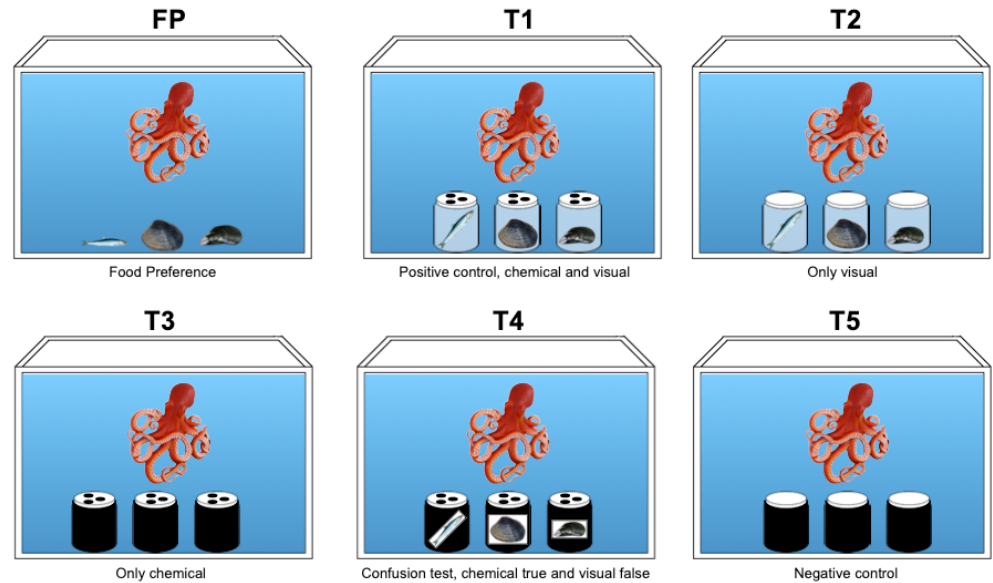
Figure 2. Experimental design to establish the sensorial hierarchy in food choice in Octopus vulgaris between chemical and visual cues. Food preference test ( FP ); food types provided in the transparent screw-jars with pierced lids ( T1 ), positive control, both chemical and visual cues; food types in transparent screw-jars with no-pierced lids ( T2 ), only visual cues; food types in blind screw-jars with pierced lids ( T3 ), only chemical cues; food types in screw-jars with pierced lids with outside a photo of food (anchovies, clam, mussel) that is different from the food inside ( T4 ), chemical true and visual false cues; food types inside blind screw-jars with no-pierced lids as control ( T5 ), negative control, both chemical and visual cues are absent.